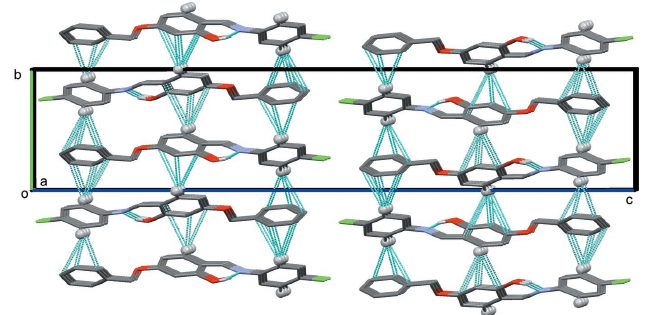
Figure 3 A view along the a axis of the crystal packing of compound (I). The intramolecular O—H (cid:2)(cid:2)(cid:2) N hydrogen bond and the intermolecular C— H (cid:2)(cid:2)(cid:2) (cid:2) interactions are represented by dashed lines (see Table 1), and only the H atoms (grey balls) involved these interactions have been included.